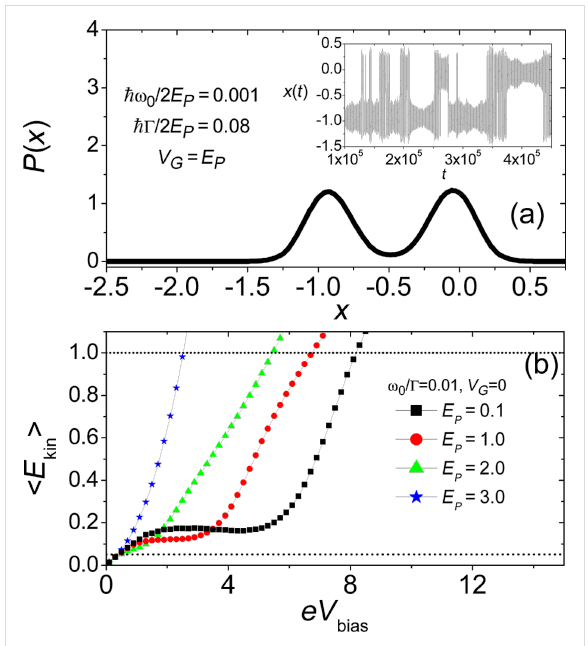
Figure 3: Analysis of the validity of the adiabatic approximation. Panel (a): Dimensionless position distribution probability for eV bias /2 E P = 0.1. Inset of panel (a): Solution of the Langevin Equation (Equation 27) for the same values of parameters as in the main plot. Panel (b): Average kinetic energy as function of the bias voltage for different inter- action strengths E P . Adapted from